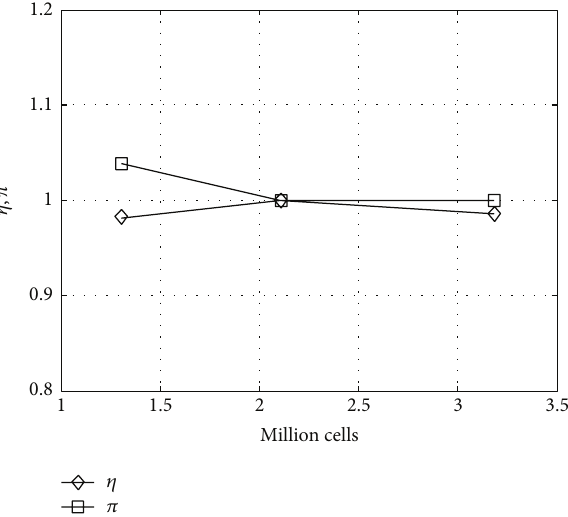
Figure 4: Stage efficiencies and pressure ratios with different grids.